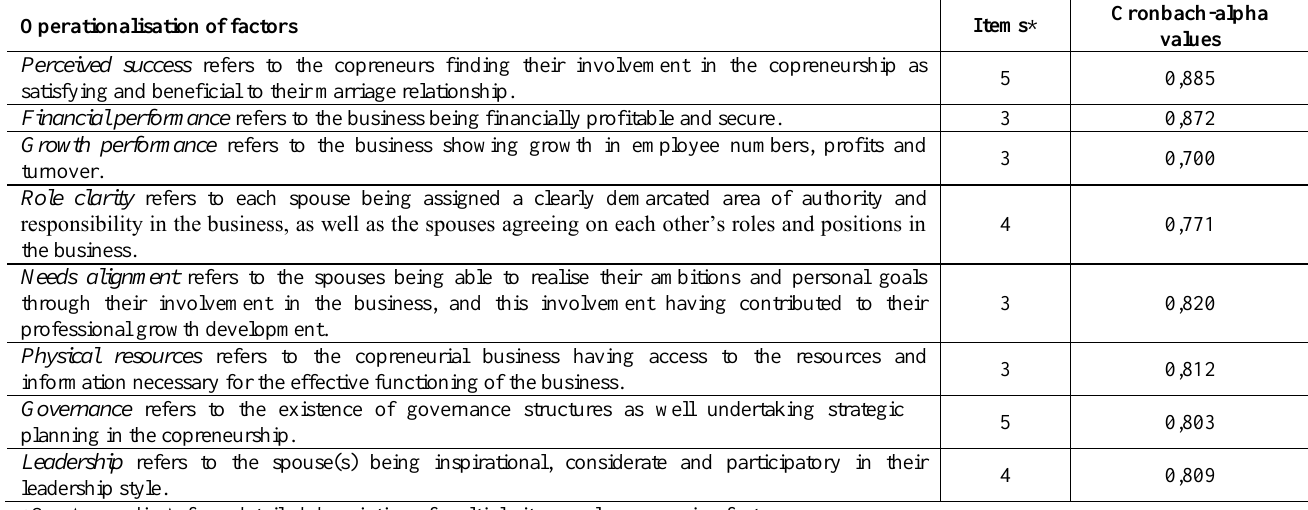
Table 2: Measurement instrument analyses Operationalisation of factors Items *